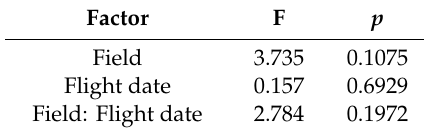
Figure 7. UAV vine height versus measured vine height by field and date and 95% confidence interval. The red line is the fitted linear function and the black line represents the 1:1 line. The root-mean-square error (RMSE) and the coefficient of determination (R 2 ) derived from the linear regression fit are included ( p < 0.0001). Field A: ( a ) July and ( b ) September, Field B: ( c ) July and ( d ) September. Table 4. F and p -values of the two-way ANOVA for vine height